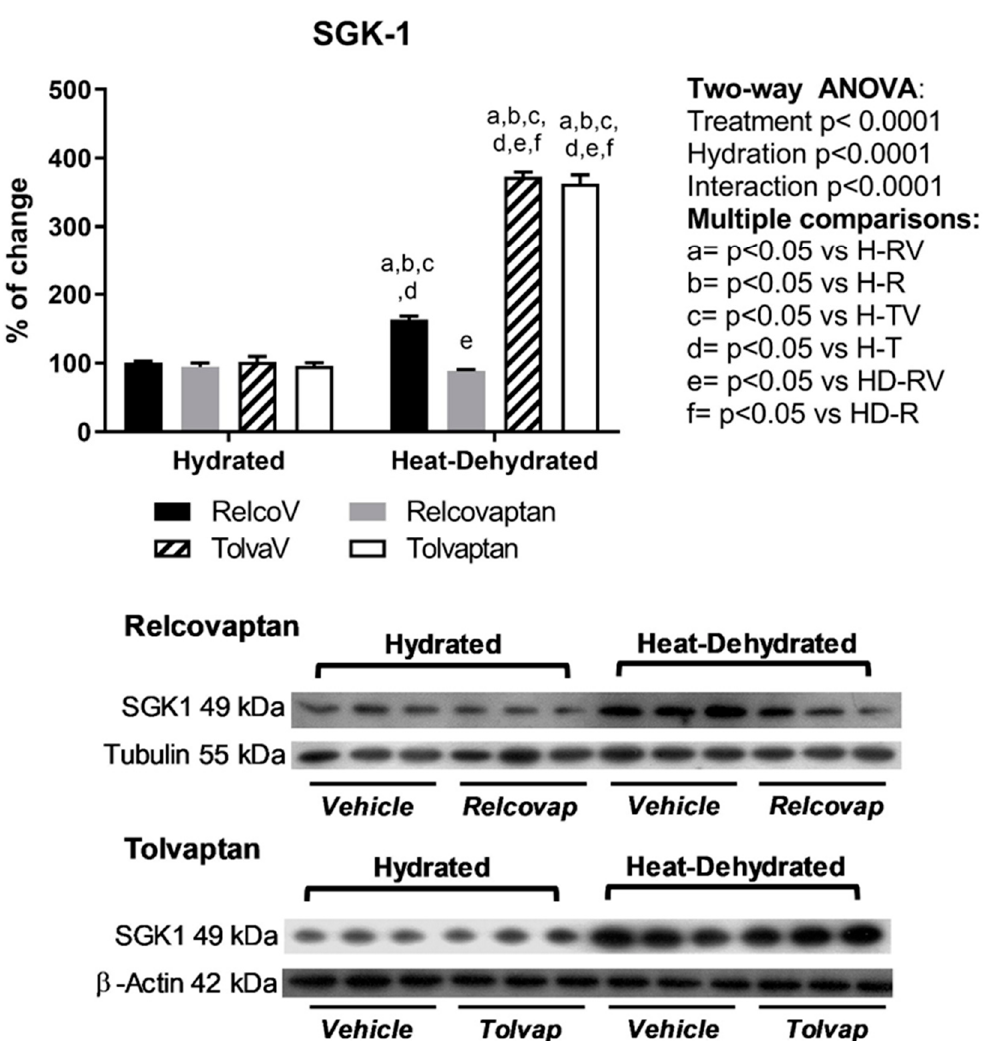
Figure 5. Effects of relcovaptan and tolvaptan on glucocorticoid-inducible kinase 1 (SGK1). Relcovaptan prevented the overexpression of SGK1 in heat stress-dehydrated rats rehydrated with a 10% fructose beverage. For western blotting, three random samples per group were selected. Proteins of interest and the respective loading controls were run independently at the same time using the same conditions. The raw dataset is available in the Supplementary Materials.